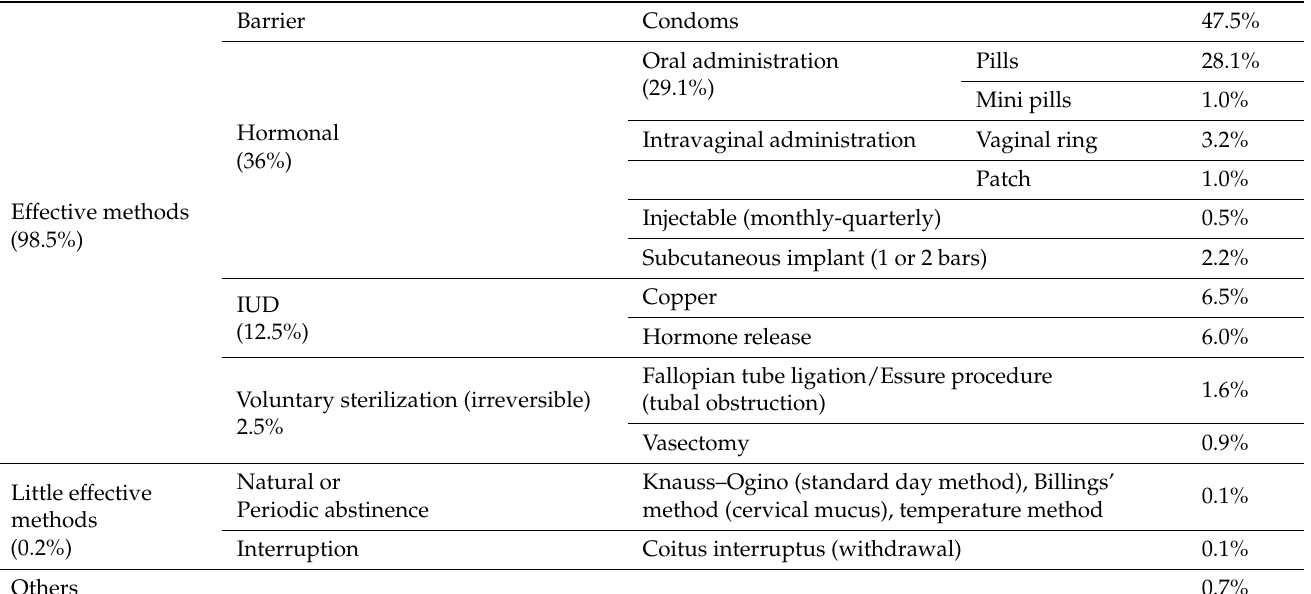
Table 4. Distribution of the use of contraceptive